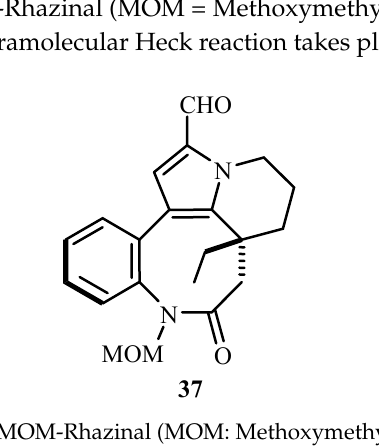
Figure 4. Ligands and catalysts employed for Heck reaction reported in review by Kobeti ć and Biliškov [14].